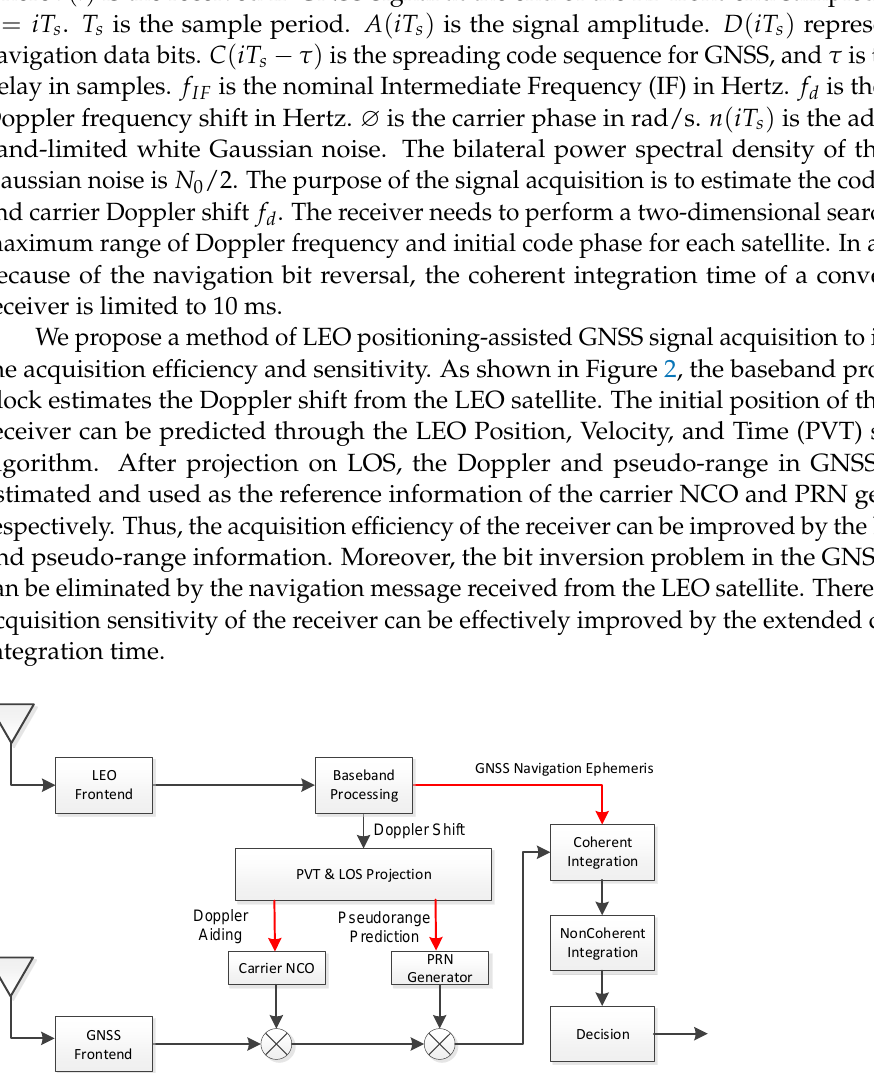
Figure 2. LEO-assisted GNSS signal